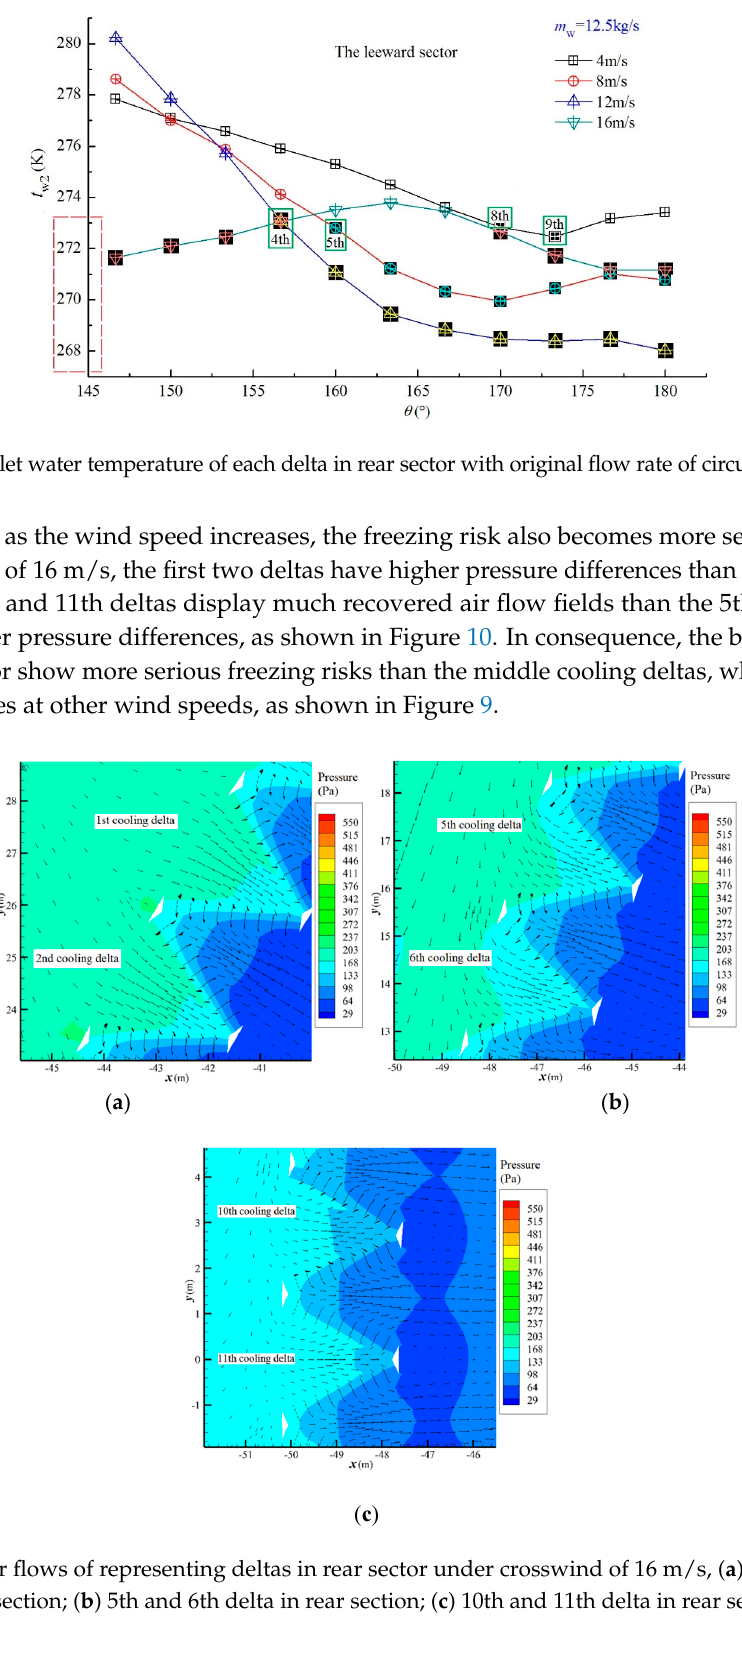
Figure 8. Air flows of representing deltas in rear sector under a crosswind of 12 m/s, ( a ) 1st and 2nd delta in leeward section; ( b ) 8th and 9th delta in leeward section.